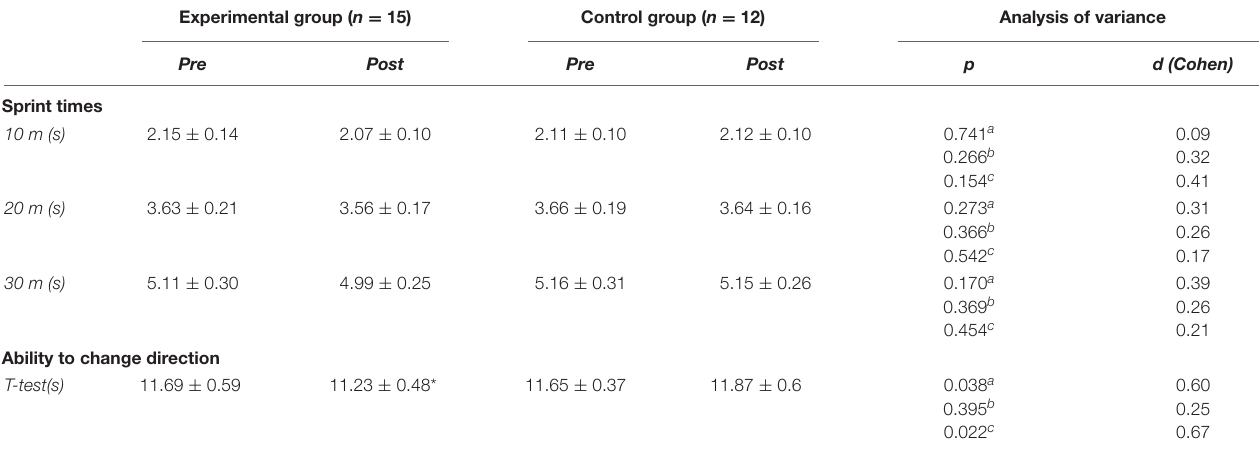
TABLE 6 | Comparison of sprint times between experimental and control groups before (pre) and after (post) the 8-week trial. Experimental group ( n = 15) Control group ( n =